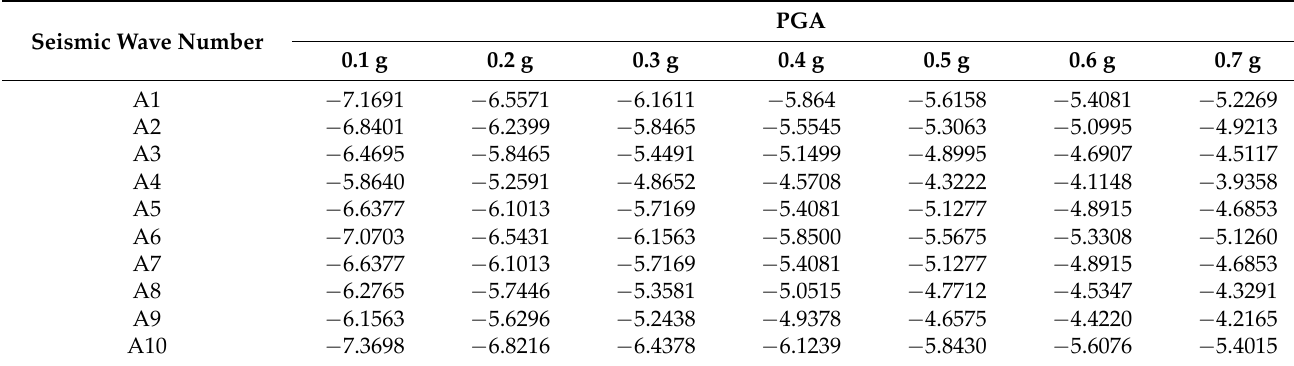
Table 2. Natural logarithmic values of maximum inter‑story displacement angles of structures under the action of seismic waves of different intensities.